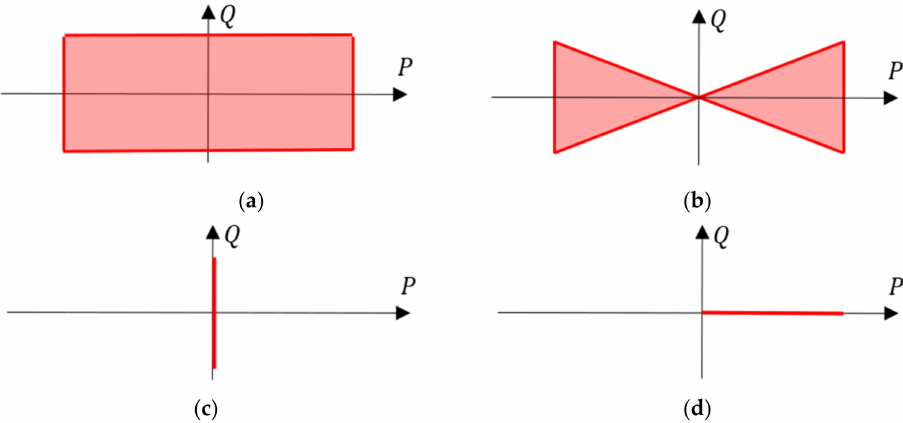
Figure 2. Typical PQ domains for grid-connected converters: ( a ) rectangular profile; ( b ) butterfly profile; ( c ) reactive power only; ( d ) zero-Q